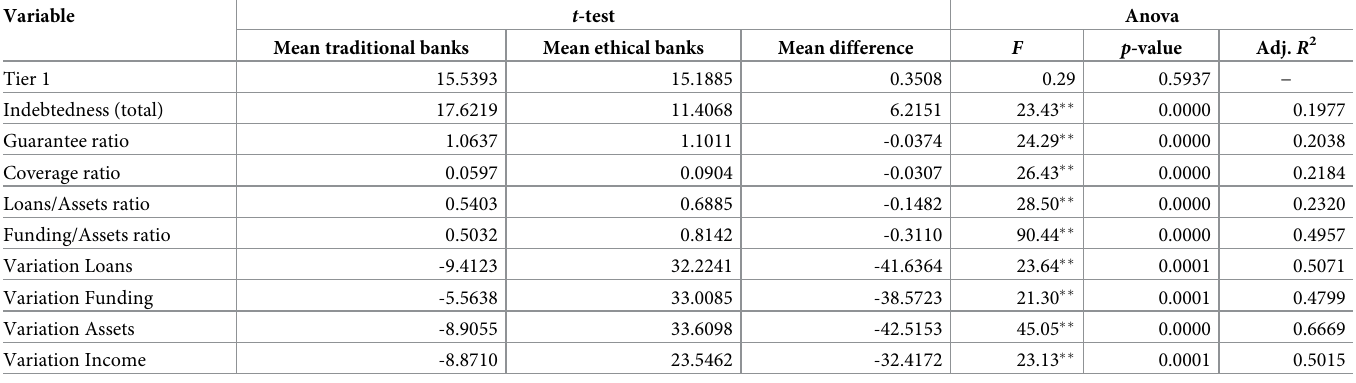
Table 8. Comparison between ethical and traditional